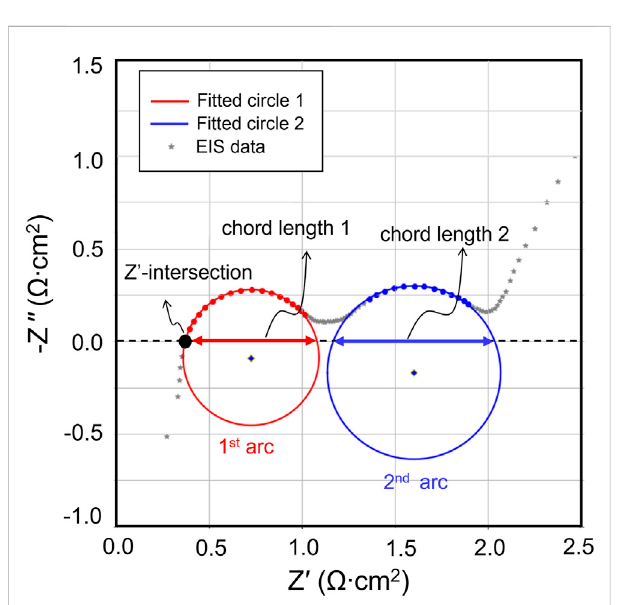
FIGURE 2 An example of quick EIS fi tting. The raw EIS data is shown in the greydots. The redandbluecircles aretheleastsquare fi ttingresults of the fi rst and second arc, respectively. On each of the circles, the red and blue dots represent the range of fi tting. Three geometry features of interest, Z ′ -intersection and chord length of 1 st and 2 nd arc, are marked accordingly in the diagram.